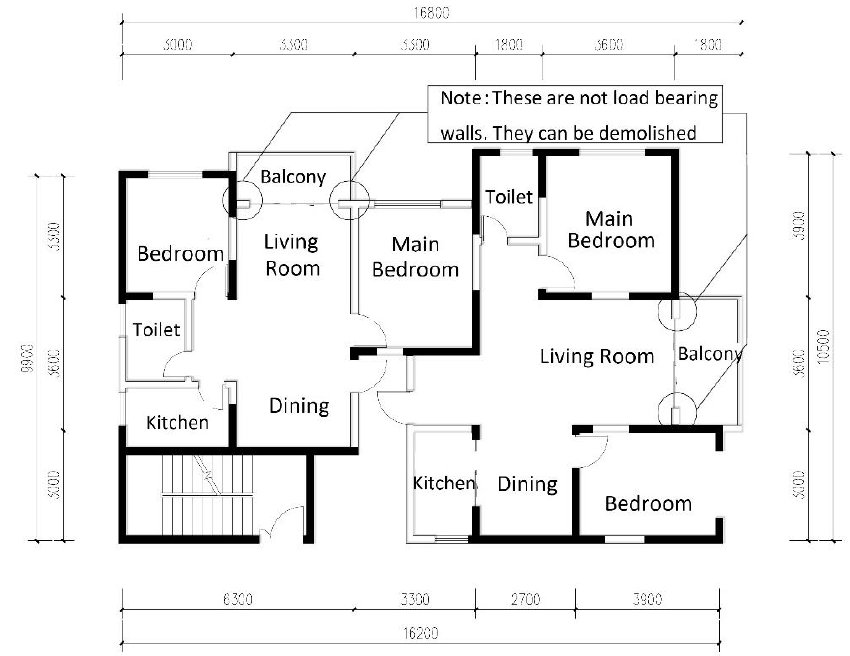
Figure 8. Walls between balconies and the living room and dining room redefined as non-load-bearing walls.